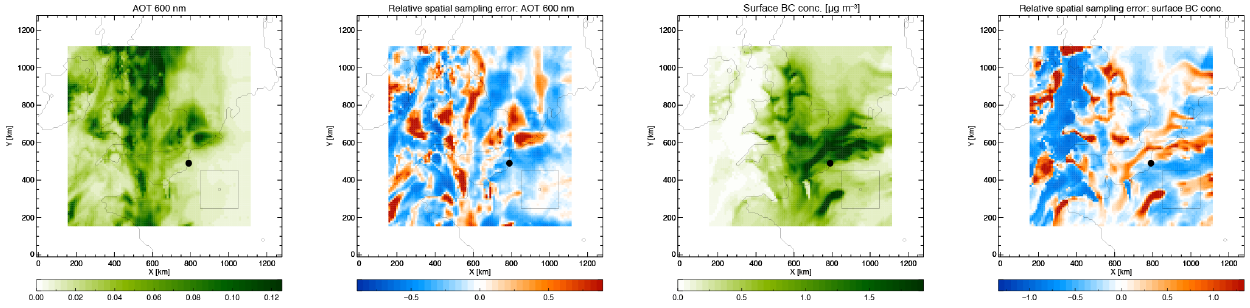
Figure 2. Snapshots of the simulated field and the relative spatial sampling error in the observation of AOT and surface black carbon concentration, over W. Europe exactly 10 days into the simulation by WRF-Chem MADE. Two square boxes (10 × 10 and 210 × 210km) and a single location (fat dot), south of Calais, France, are also shown. Note that the high-resolution simulations encompass the whole region shown, while our analysis is only made for the coloured domain.